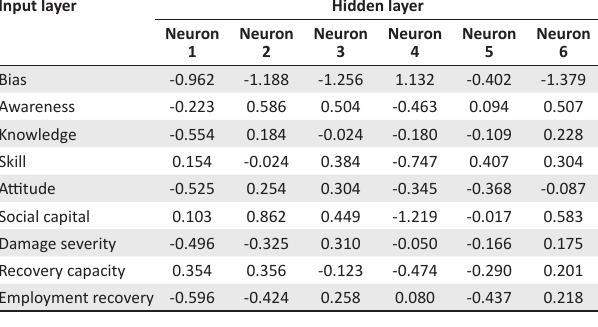
TABLE 8: Estimated coefficients by the neural network for hidden layer, Rudbar.